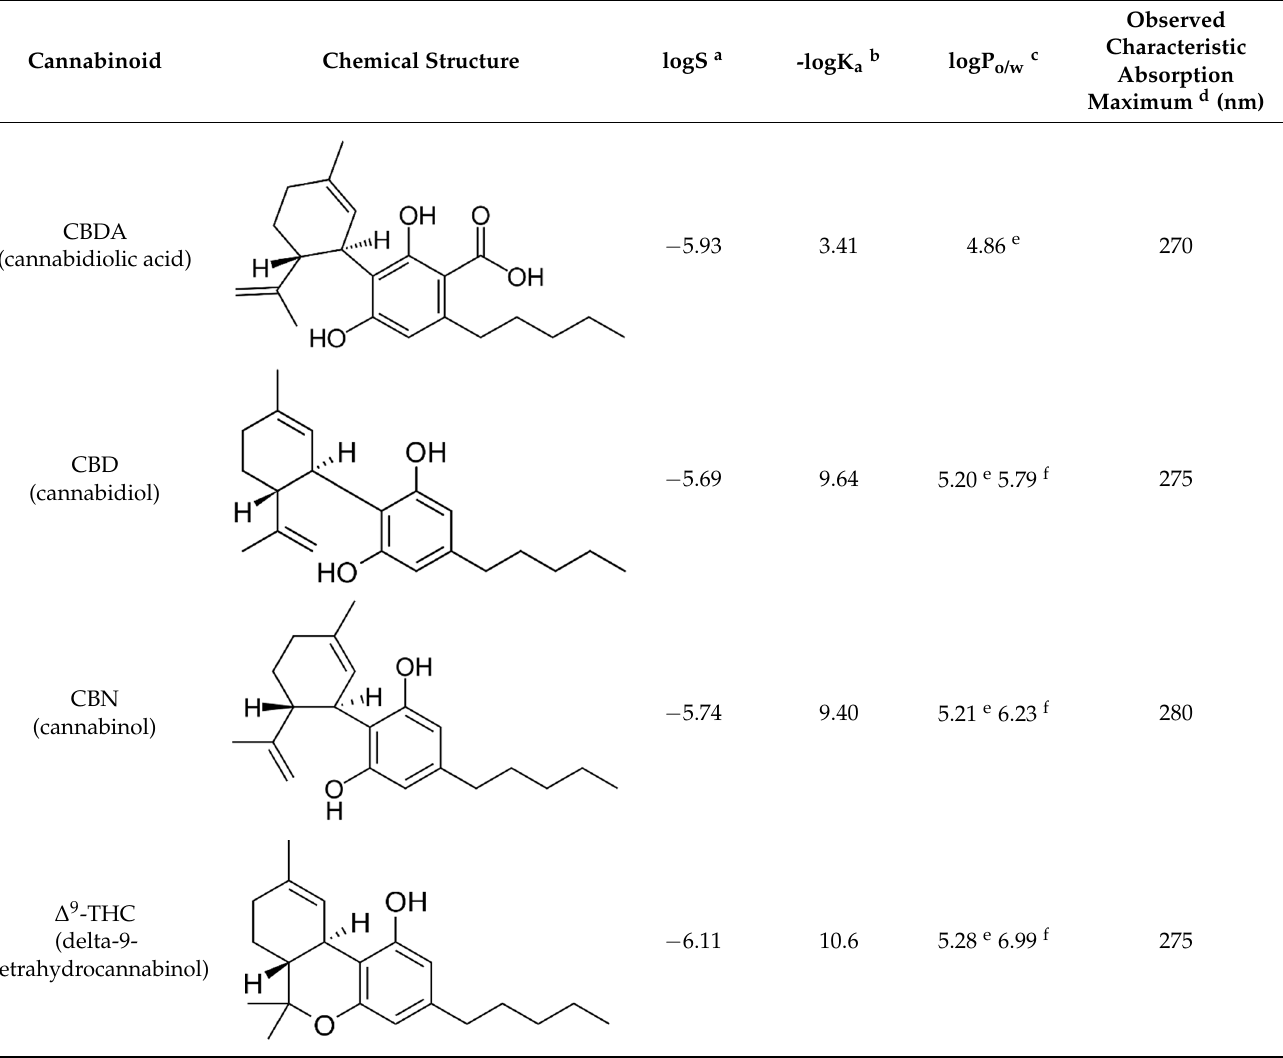
tetrahydrocannabinol)